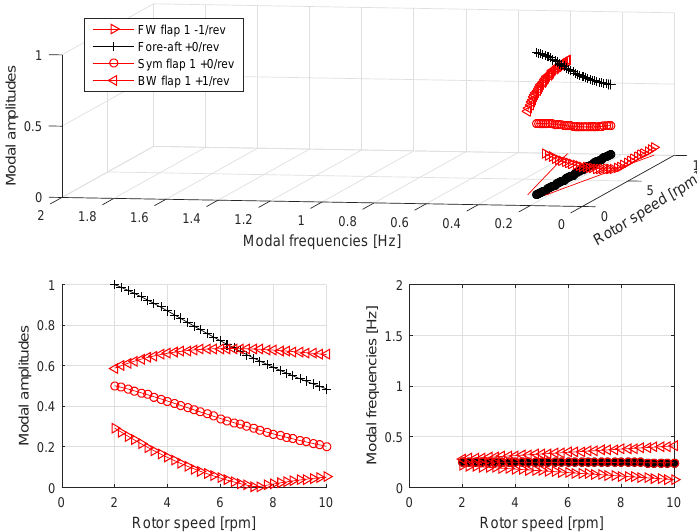
Figure 5. Harmonic modal components for the three-bladed turbine mode dominated by tower fore–aft motion. Top panel: modal amplitudes plotted versus rotor speed and frequency of the particular harmonic component. Lower left panel: projection onto the plane of modal ampli- tudes and rotor speed. Lower right panel: projection onto the plane of component frequencies and rotor speed (periodic Campbell diagram). Filled black circles show the principal modal frequencies in the frequencies and rotor speed planes. Only modal components with amplitudes larger than 10% of the overall maximum amplitude are plotted.